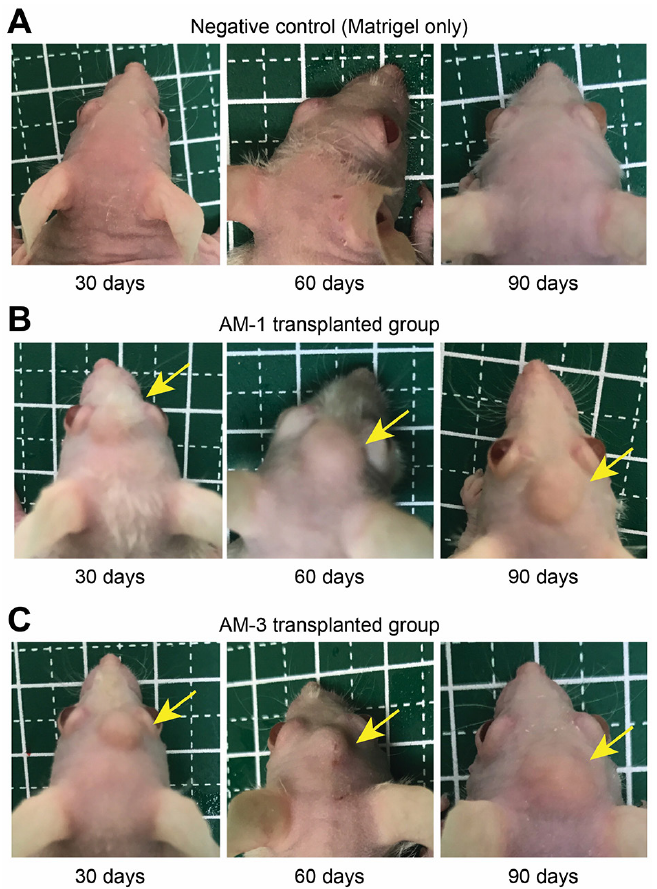
Figure 1- Images of the heads of mice at each time point: 30, 60, and 90 days. (A) Negative control group: transplanted with Matrigel without cells. (B) AM-1 group: transplanted with AM-1 cells with Matrigel. (C) AM-3 group: transplanted with AM-3 cells with Matrigel. Yellow arrows indicate the tumor